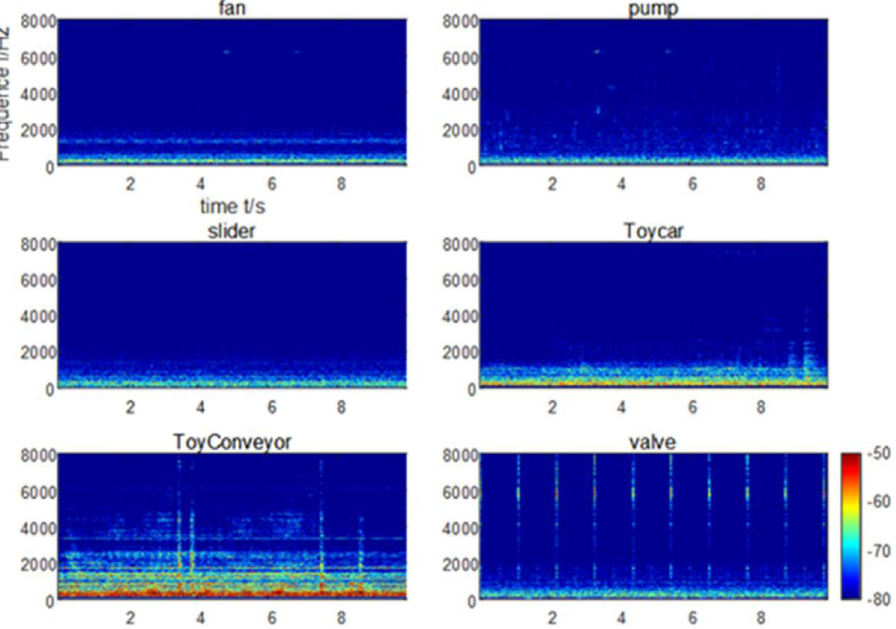
Fig. 1. Various data Log-Mel spectrogram. The horizontal axis represents time, and the vertical axis represents